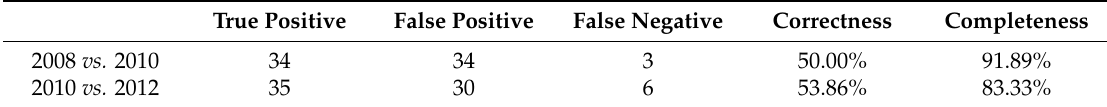
Table 4. The completeness and correctness of detected change.